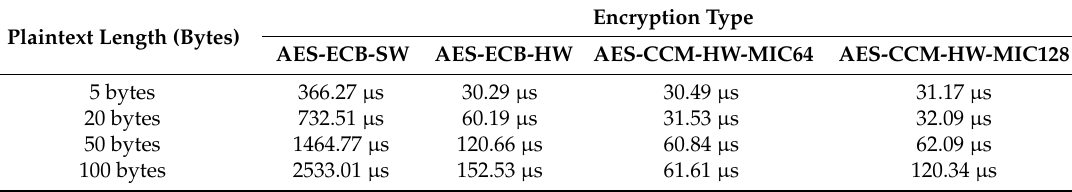
Table 2. Average encryption times of different encryption types in different payload lengths.